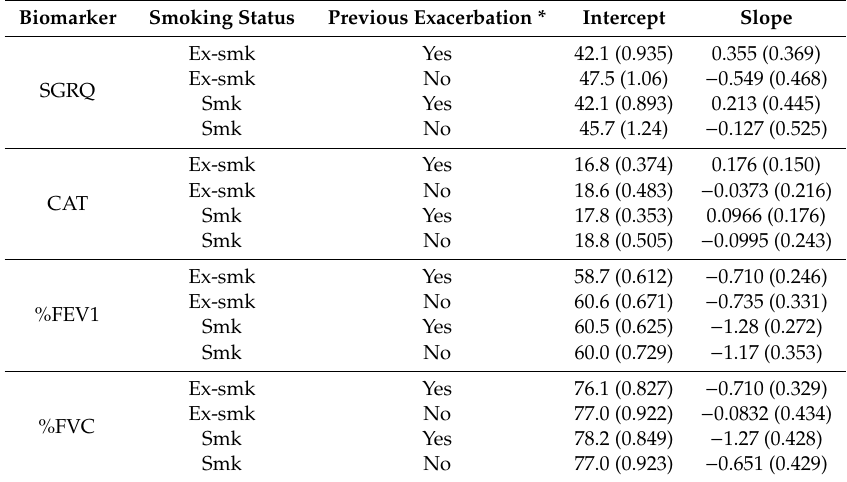
Table 1. Estimated parameters for the progression of COPD by LMEM.